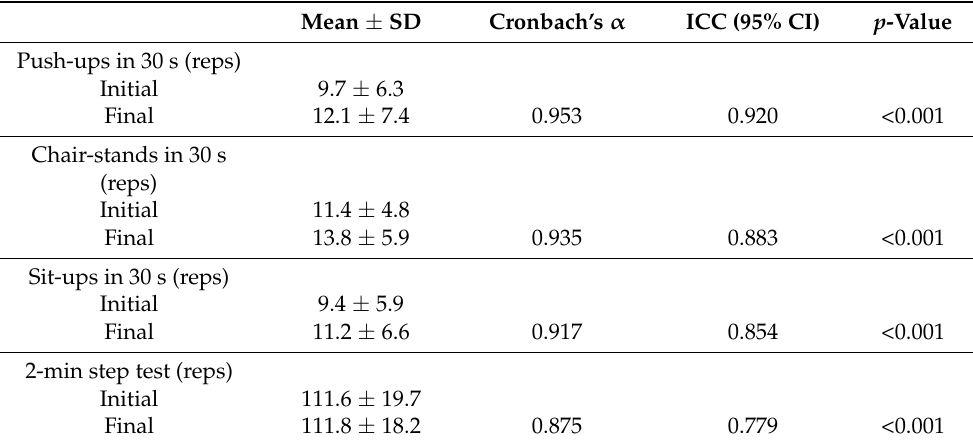
Table 2. Test-retest reliability of health-related physical fitness tests ( N =